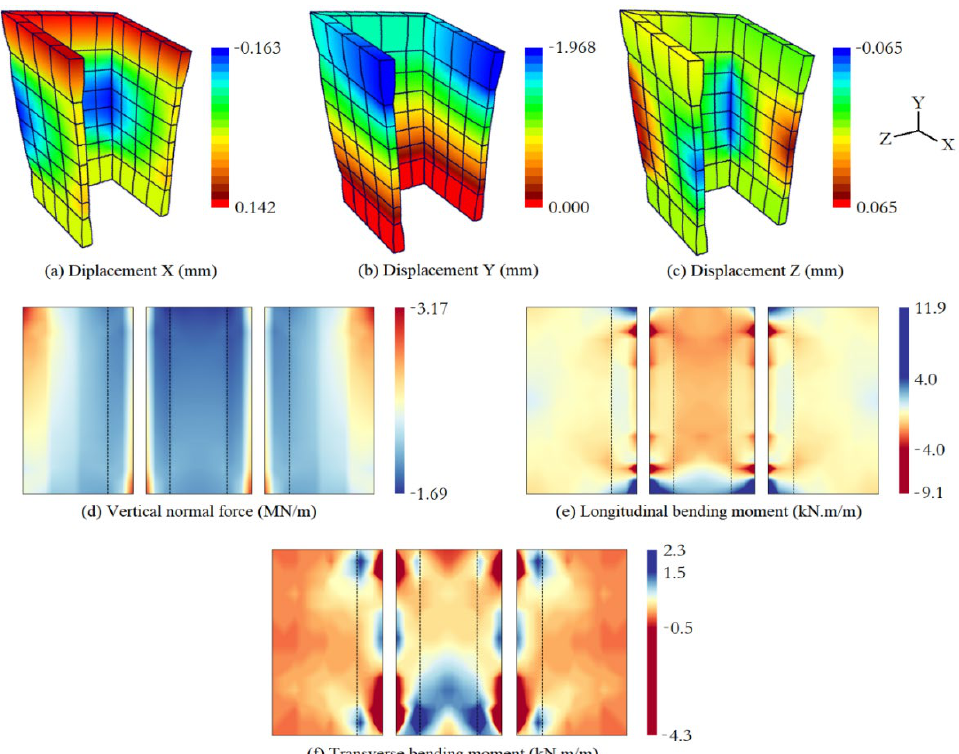
Figure 11. U-shaped shear wall displacements and internal forces diagrams (symmetric)